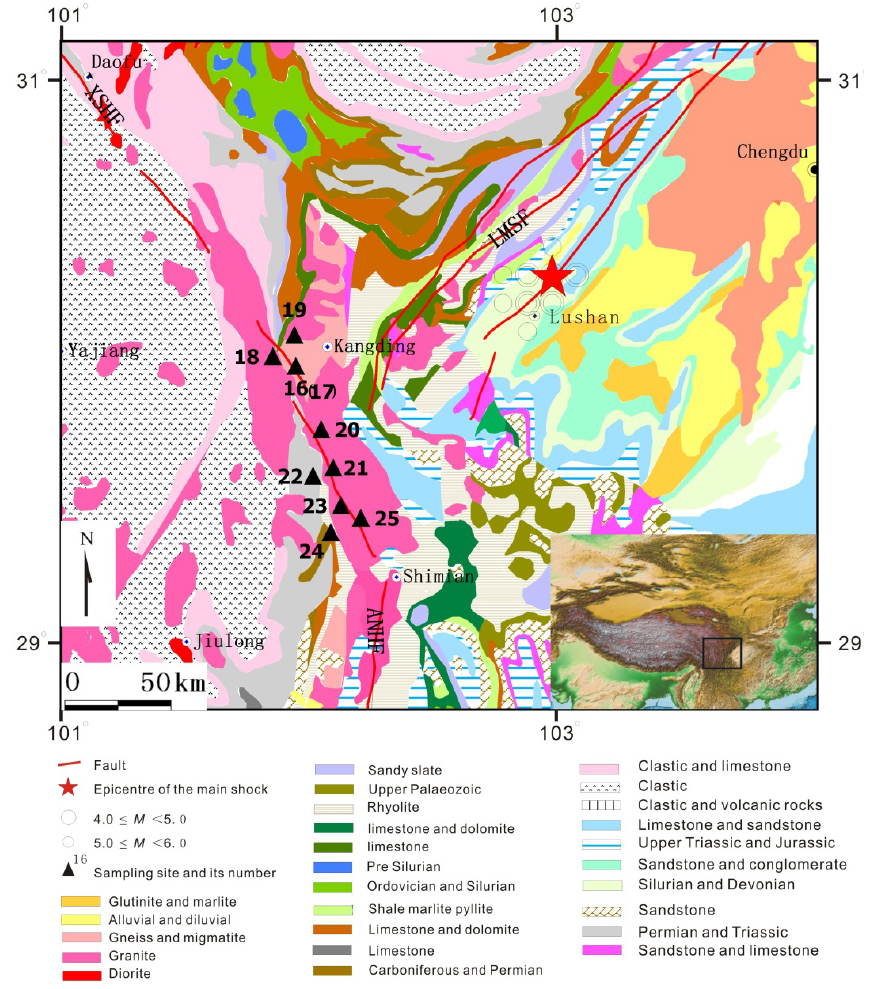
Figure 1. Geological map of the studied region: the insert shows a map of Asia; the square shows the location of the studied region. The sampling sites are distributed in the southeast segment of the XSHF